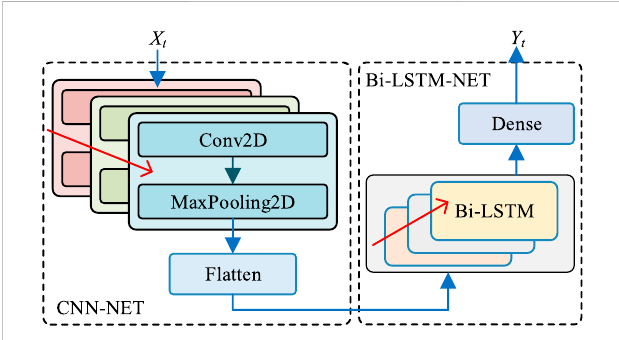
FIGURE 4 CNN-Bi-LSTM hybrid model.